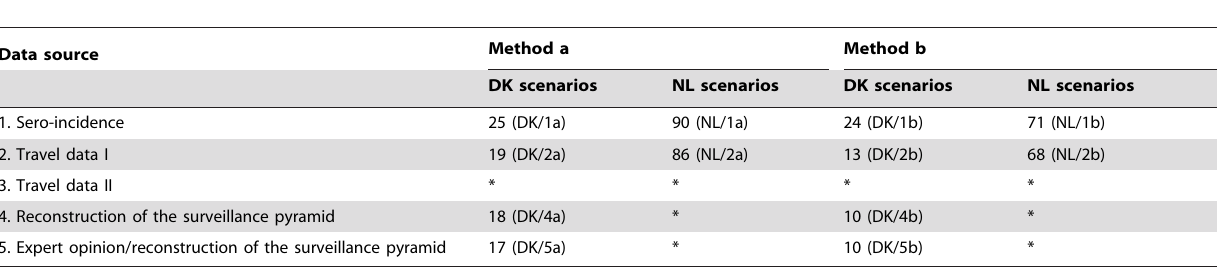
Table 4. Expected increase in the incidence (cases/100,000) of reported domestic salmonella cases in Sweden in 2010, if the Swedish salmonella control had been substituted with a programme similar to the Danish (DK) or the Dutch (NL) control programme.